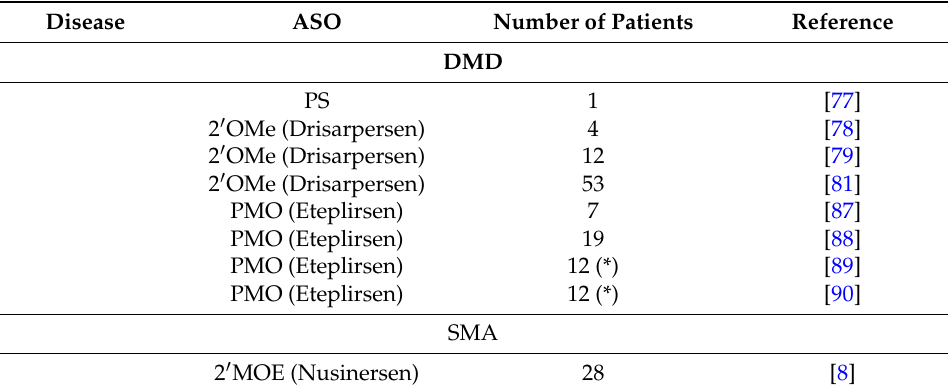
Table 1. Summary table of clinical trials based on ASO therapy for treating neuromuscular disorders. DMD, Duchenne Muscular Dystrophy; PS, phosphorothioate; 2 (cid:48) OMe, 2 (cid:48) -O (cid:48) methyl; PMO, phosphorodiamidate morpholino; SMA, Spinal Muscular Atrophy; MOE, 2 (cid:48) - O -methoxyethyl. (*) indicates that the same patient group was monitored in both the two studies. Disease ASO Number of